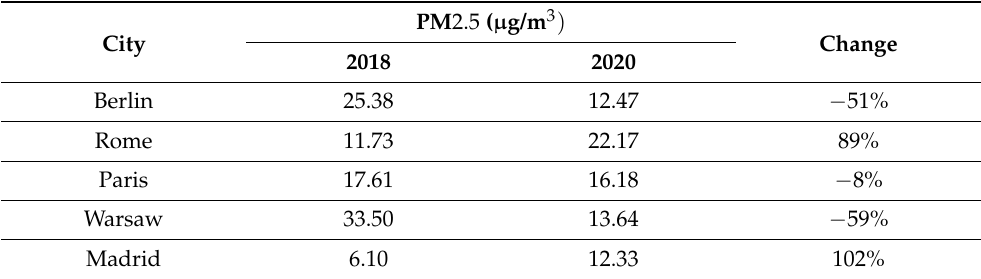
Table 5. The average change in PM 2.5 concentration on 20 March to 15 April 2018, and 2020 in selected European capitals.